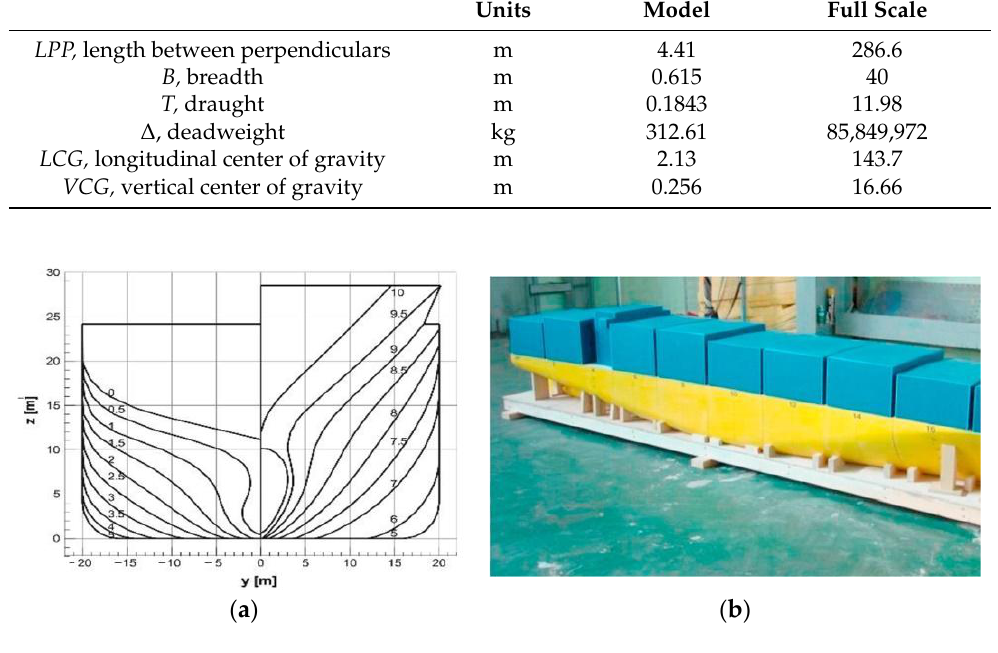
Figure 1. Experimental setup of a 6750 TEU containership: ( a ) body plan; ( b ) actual model. The prescribed regular head-sea waves are given in Table 2. With the intention of limiting excessive surge of the ship, soft mooring is imposed with a resulting surge natural period of 11.8 s. This is achieved using four springs, k 1 , k 2 , k 3 and, k 4 , all of which have the same stiffness of 56 N/m. The angle α between pairs of springs at the bow and stern is equal to 45 ◦ . The mooring arrangement is shown in Figure